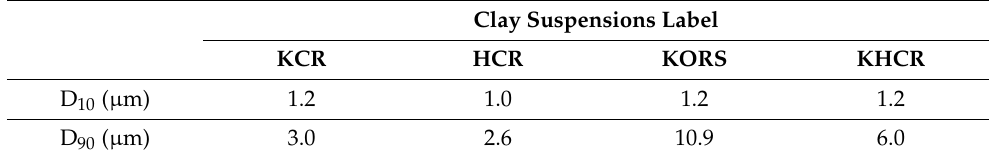
Table 2. Characteristic grain size (derived from Figure 2) of the prepared clay suspensions.